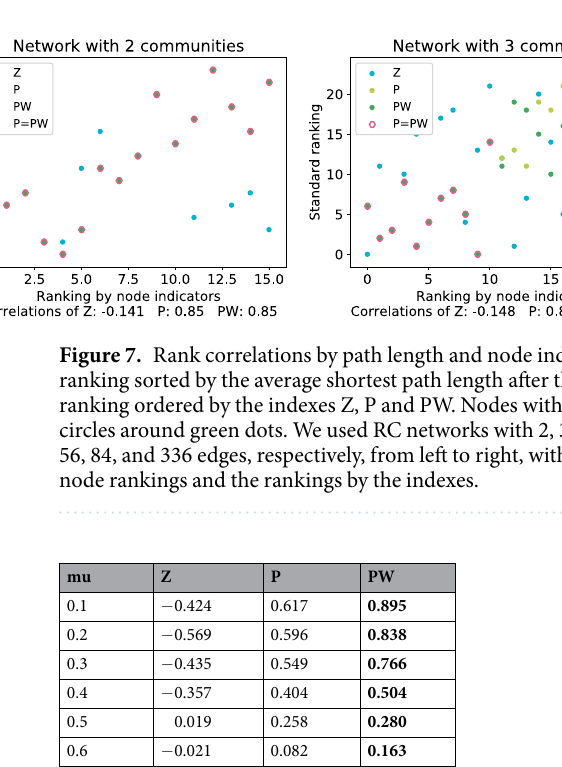
Table 4. Rank correlation in LFR networks with different link